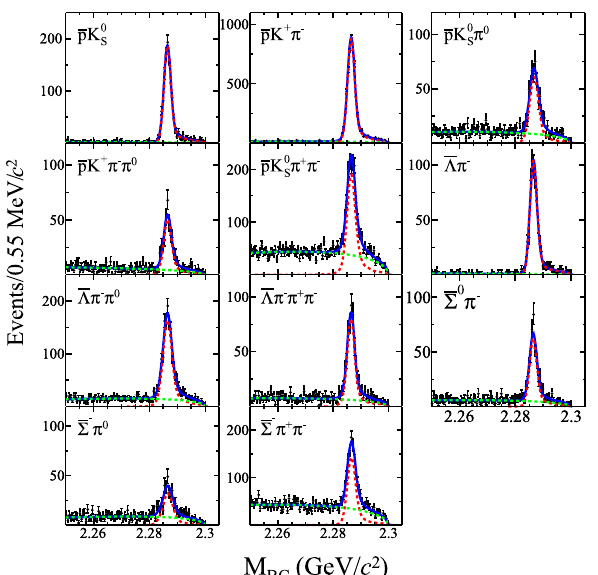
Fig. 1 Fits to the distributions of M BC in data sample for different ST ¯ (cid:2) − c modes, where the black dots with error bars are data, the blue lines are the fit results, the dashed red lines are signal shapes, and the dashed green lines are background shapes